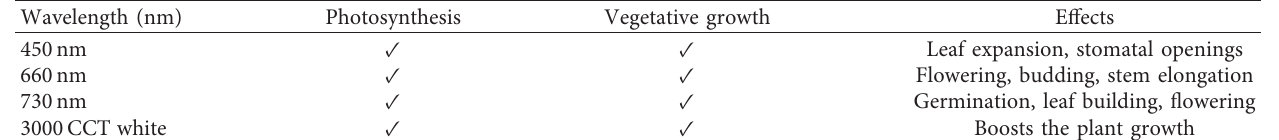
Figure 7: Illumination with 660nm and 730nm. Table 1: Effects of the particular wavelengths.